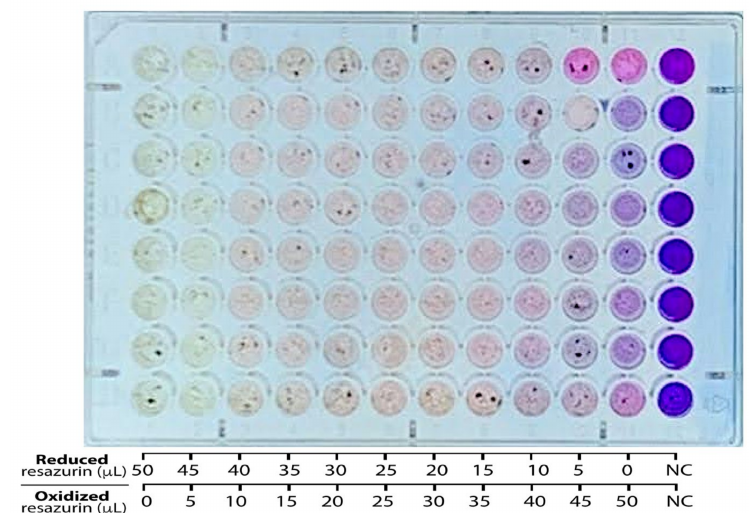
Figure 3. Oxidation-reduction gradient obtained with the mixture of the reduced and oxidized forms of the resazurin solution at the final concentration of 40 µ M *.* Mixtures of reduced and oxidized forms of RZ and respective volumes added in the microplate wells containing PD medium prepared with 0.025 M phosphate buffer, final pH 5.0 and 50 µ L of M. musicola or P. oryzae Triticum lineage inoculum suspension (10 4 mycelial fragments · mL − 1 or water as the negative control). RD = reduced resazurin (autoclaved for 15 min). OR = oxidized resazurin (no autoclaving). NC = negative control (no mycelium fragments